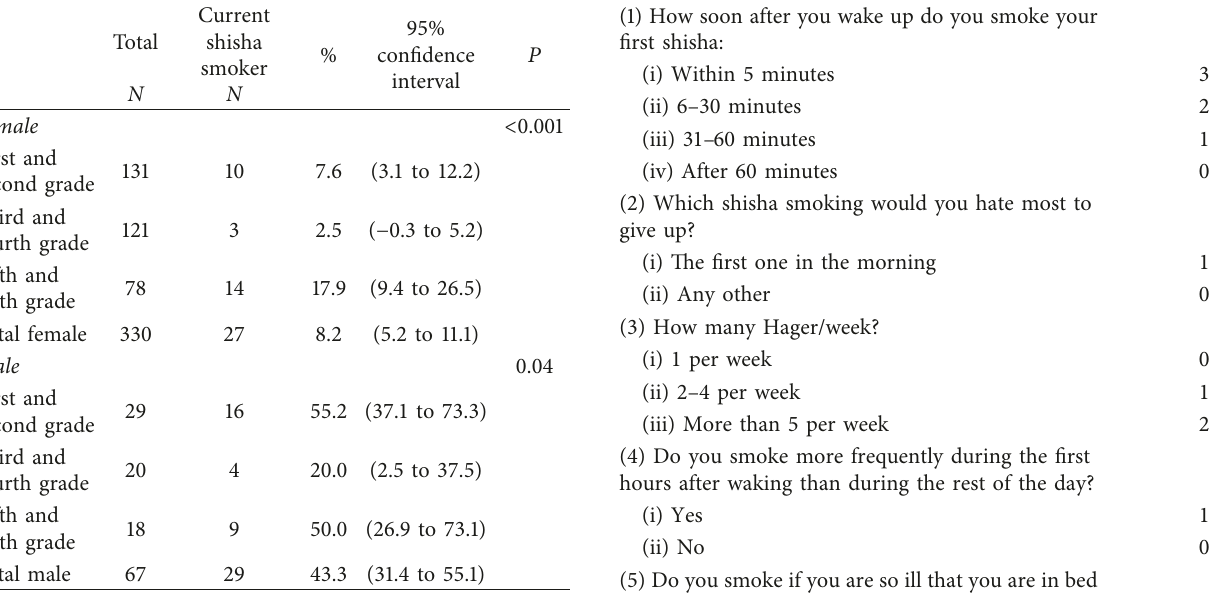
Table 7: The Modified Fagerstr¨om Nicotine Test for Dependence scale.